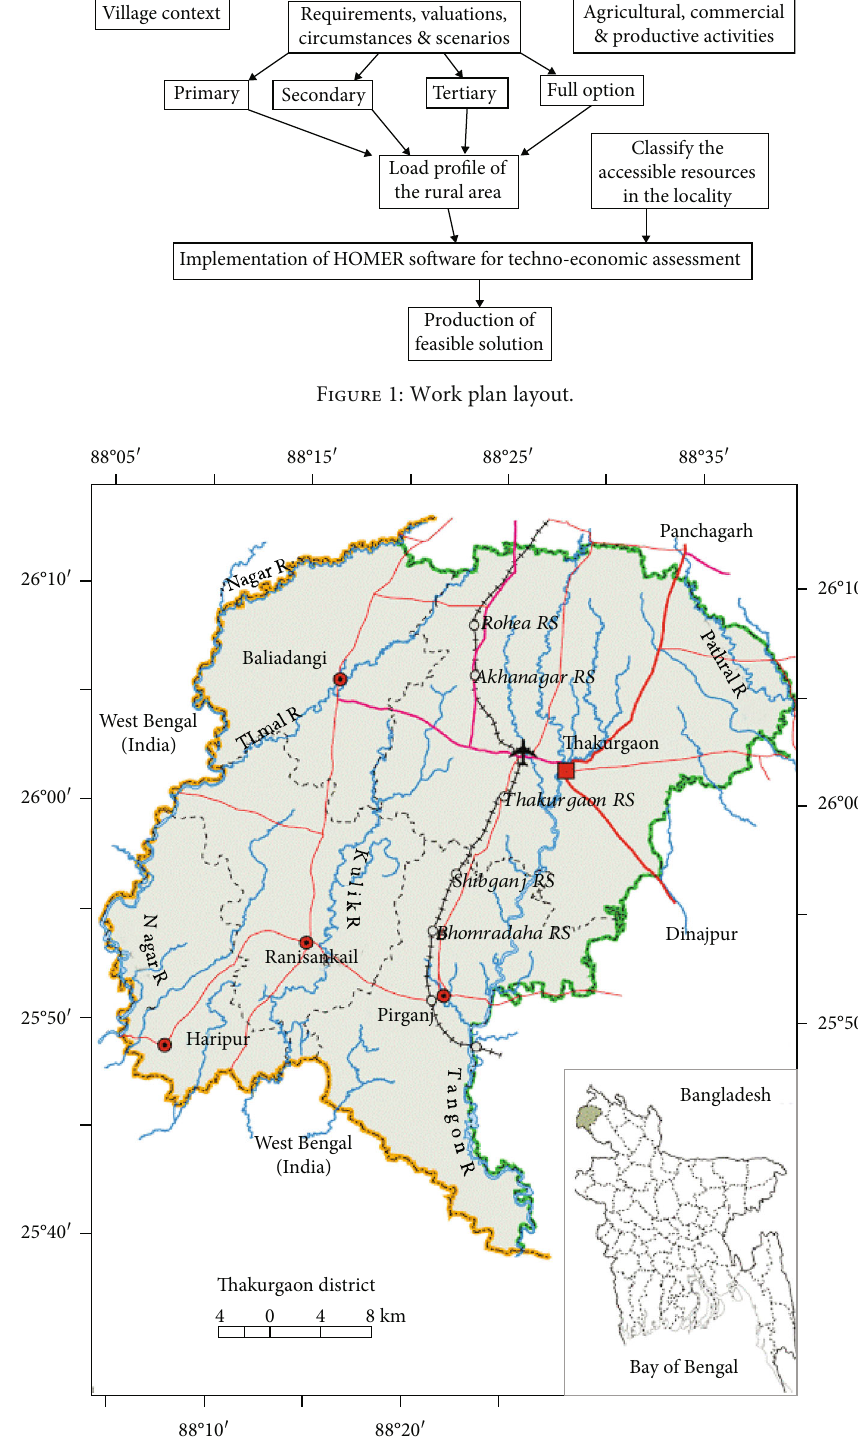
Figure 2: Geographical location of Thakurgaon district in Bangladesh.